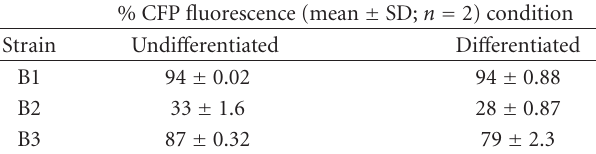
Table 2: Quantitative comparison of the CFP-fluorescent cell frac- tions of cultures under undi ff erentiated and di ff erentiated condi- tions. Flow cytometry quantification of the R2 region of flow his- tograms (see, e.g., in Figure 5) for three fluorescent cell clones (same as Figure 2). Data are the average % fluorescent cells at 24 weeks in cultures ± standard deviation (SD). Cells were analyzed under nor- mal culture conditions (undi ff erentiated) and under conditions that increase di ff erentiated progeny (di ff erentiation), as described in the